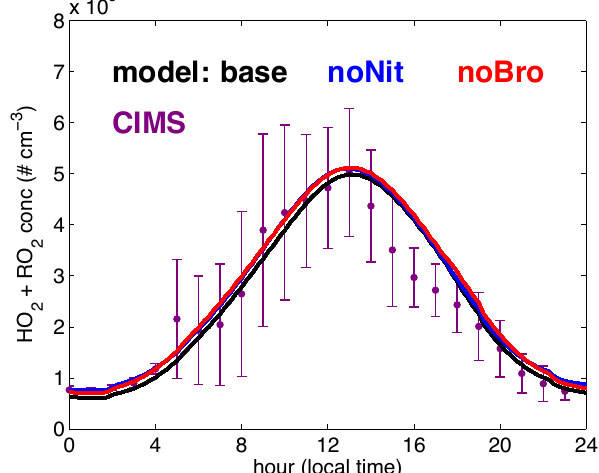
Fig. 10. Model predicted OH concentrations for the second day of the three day model run for the base, noNit, and noBro cases com- pared to hourly averaged OH concentrations for the time periods classified as influenced by local air. The error bars on the OH mea- surements indicate the standard deviation upon hourly averaging. The base case model predicted OH is below mean values of the mea- surements, but well within the error bars. Without bromine chem- istry, OH is predicted to be lower than the base case. Without snow sourced NO x chemistry, the OH concentrations are predicted to be much lower than the measured values.